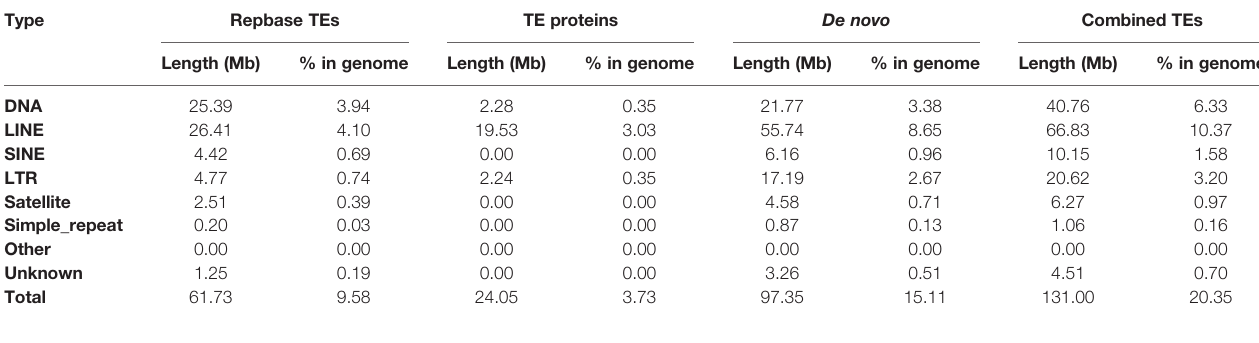
chromosome assembly, the density of genes, repeat types, and